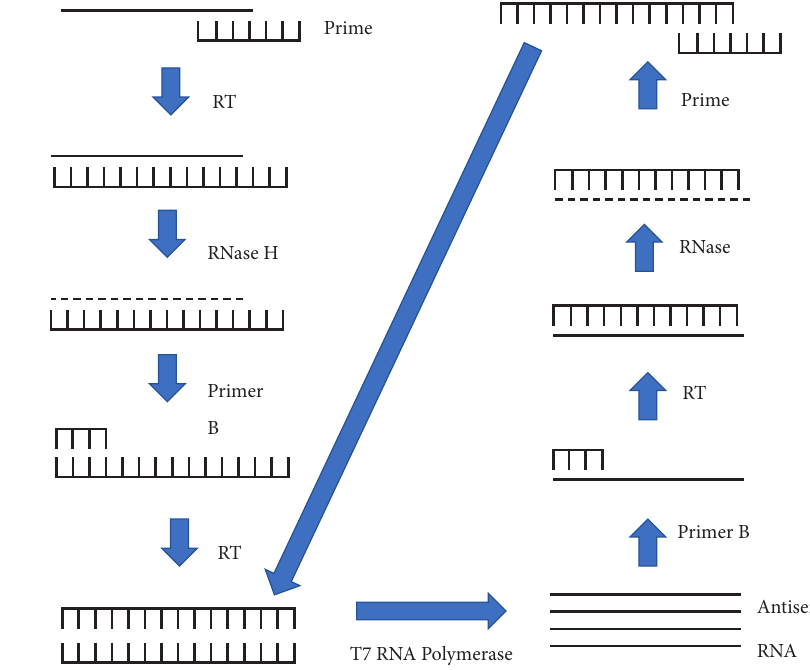
Figure 3: Diagrammatic illustration of the principles of NASBA